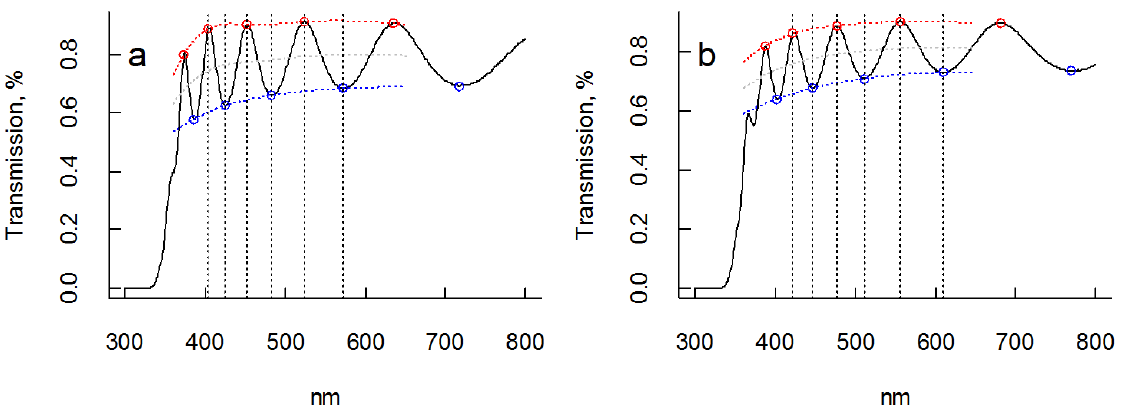
Figure 4. Transmittance spectra for a ( a ) non-oriented film, and ( b ) <001> oriented film. Positions of maxima and minima of T used in the analysis of the optical data, as well as average T over the visible wavelength region, are denoted by dashed